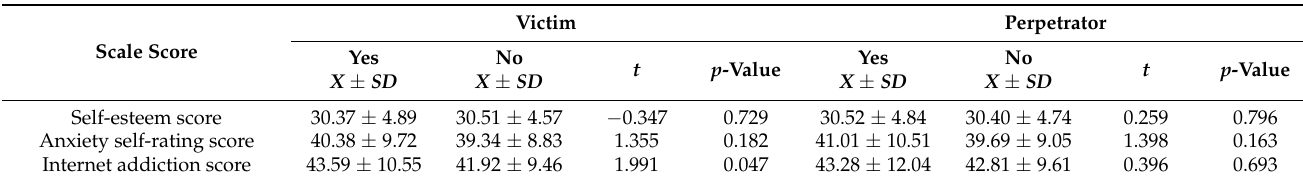
Table 4. Univariate analysis of cyberbullying in online game and self-esteem, anxiety and Internet addiction among college students.